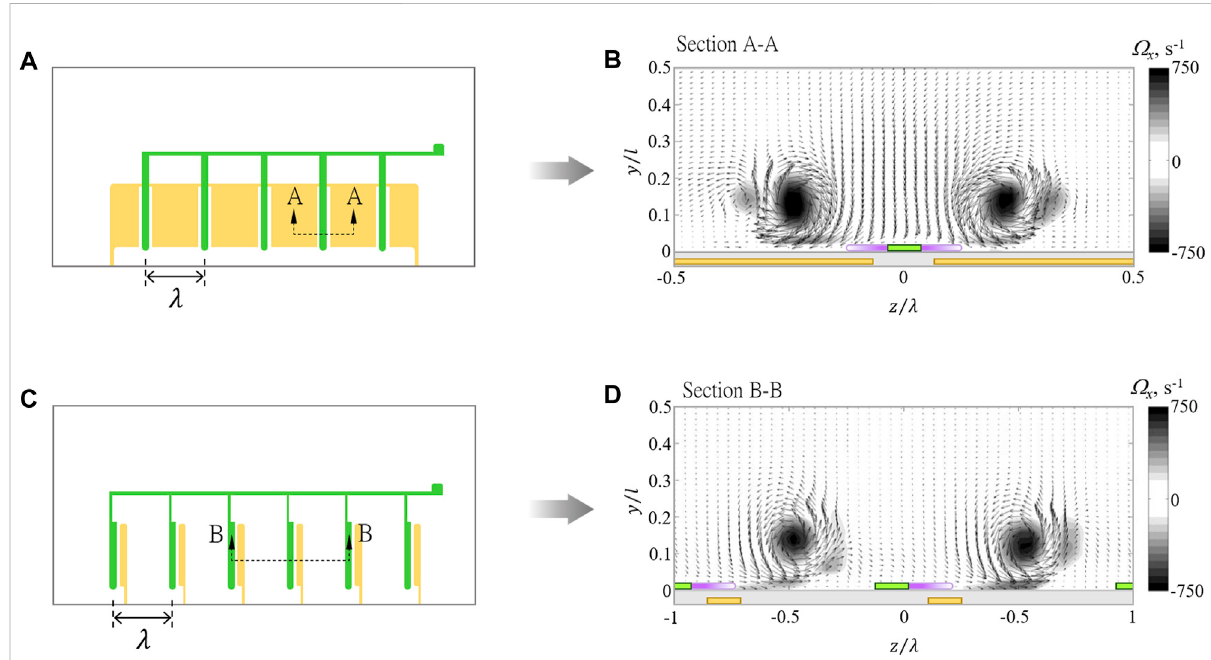
FIGURE 11 Flow of comb/ fi nger reactor with plasma only around the parallel fi ngers. (A) Ground electrode on both sides of the fi ngers. (B) Counter- rotating vortices. (C) Ground electrode only on one side of the parallel fi ngers. (D) Co-rotating vortices